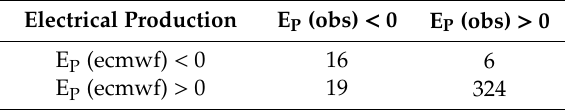
Table 4. Dichotomous analysis for the total number of forecasted (ecmwf) and measured (obs) occurrences and non-occurrences of daily negative electrical production values (E P ) for the Gemasolar power plant simulation through the SAM. The obtained E P simulated values were based on hourly DNI and meteorological data (forecasted and measured) input parameters acquired for É vora for the same period of study (from 1 July, 2017 to 30 June, 2018). Four di ff erent events of negative E P values occurrences and non-occurrences have been depicted—‘Hits’ (E P (ecmwf) < 0 and E P (obs) < 0), ‘False alarms’ (E P (ecmwf) < 0 and E P (obs) > 0), ‘Misses’ (E P (ecmwf) > 0 and E P (obs) < 0) and the ‘correct rejections’ (E P (ecmwf) > 0 and E P (obs) >